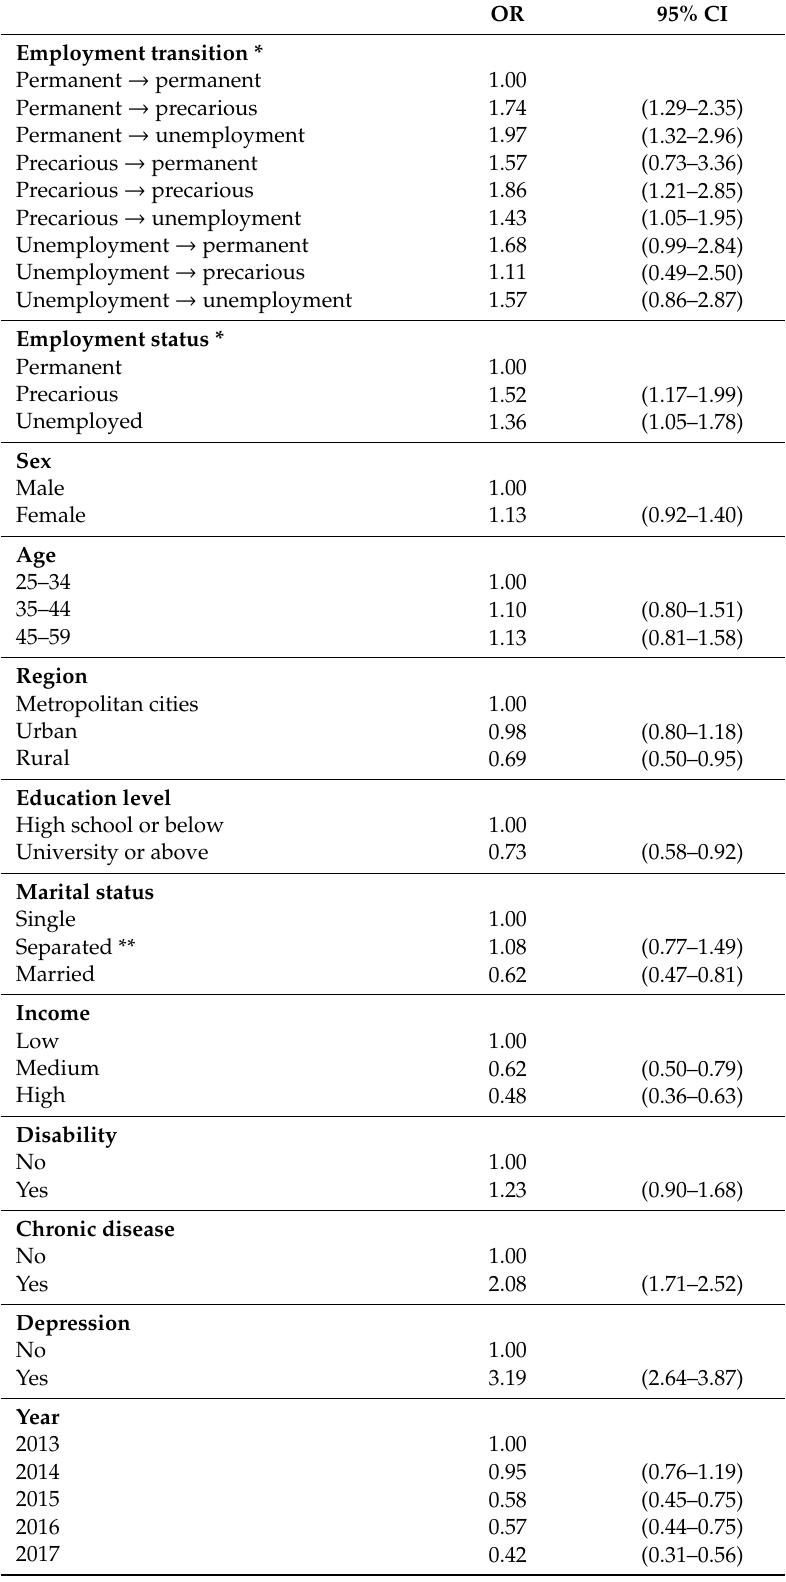
Table 2. Employment and other factors associated with suicide